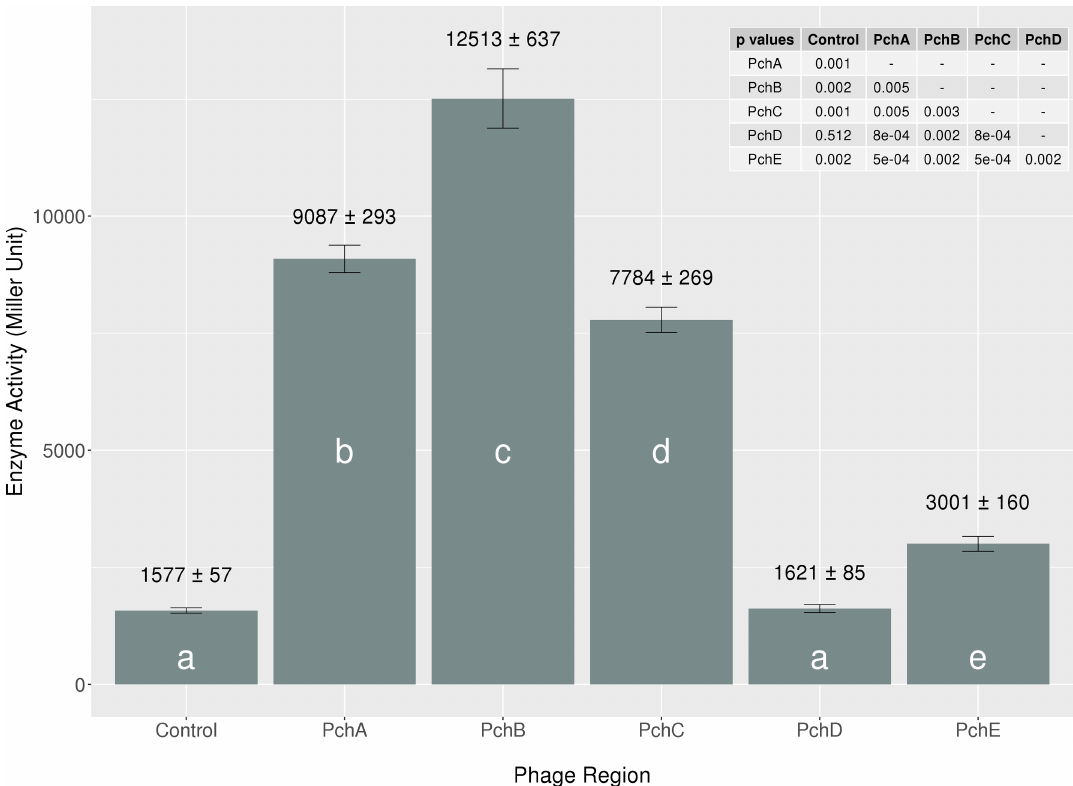
Fig 2. Effect of Pch homologues on ler expression. Comparison of the ß-galactosidase activities of strain MG1655 Δ yfdN containing a ler :: lacZ chromosomal fusion and transformed with plasmid pSE380 or pSE380 carrying cloned pch genes as indicated. The enzymatic activity is reported as Miller units. Bars represent the mean of three individual samples tested in lysogeny broth (LB) and induced with 0.1 μM IPTG. Strain means with the same letter are not significantly ( P (cid:20) 0.05) different from each